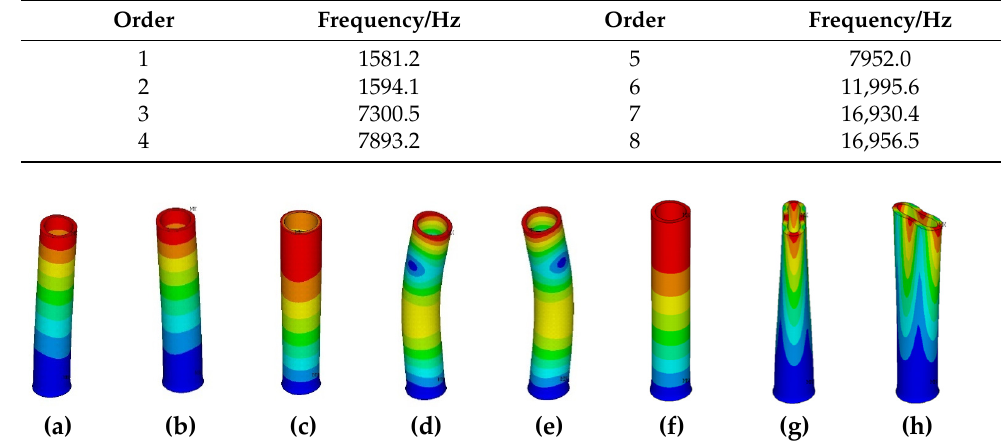
( c ) Figure 1. Structural model of the vortex reducer: ( a ) Meridional plane diagram; ( b ) Geometric model; ( c ) Grid model. The vortex reducer is composed of 18 thin ‐ walled tubes evenly distributed along the circumference of the disk cavity. The tubes are fixed on the support ring by the internal clamping ring. The tube and the support ring are regarded as an integral structure when constructing the full circle grid model of the vortex reducer. The number of elements in the vortex reducer are 380,736, and the number of nodes is 478,494. Different from the geometric model in Figure 1b, the grid model of the tube only includes the part above the support ring, that is, the part with a length of 5.2 D in Figure 1a. The number of elements in the tube is 7050, and the number of nodes is 9600. 3.2. Modal Characteristics The modal characteristics of the vortex reducer are analyzed by the Finite Element Method (FEM). Assuming that the support ring has strong rigidity, only a single tube is taken as the object of the modal analysis, and the effect of structural coupling caused by the support ring is discussed in Section 4. Next, the bottom of the tube connected with the support ring is fixed. The tube tem ‐